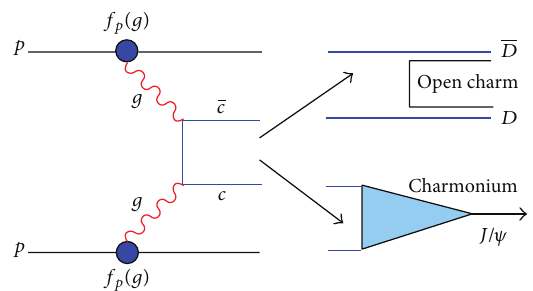
Figure 1: Schematic view of 𝐽/𝜓 production in 𝑝𝑝 collisions.